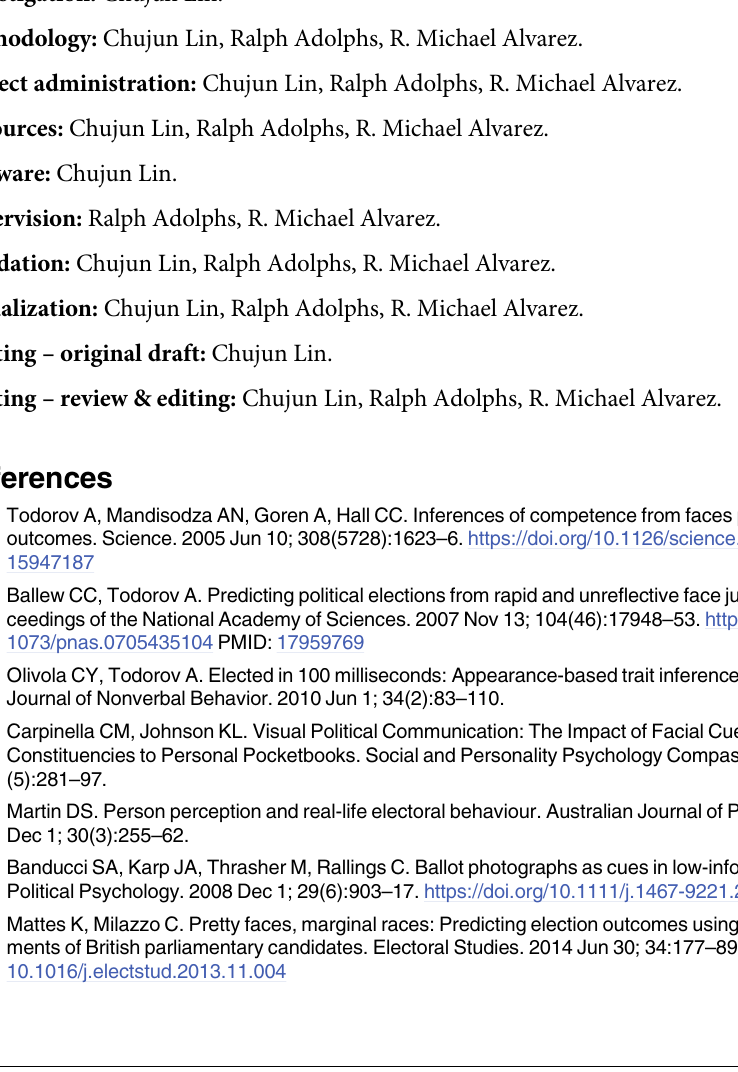
S2 Table. The effect of response time on the association between face-based trait inferences and real election